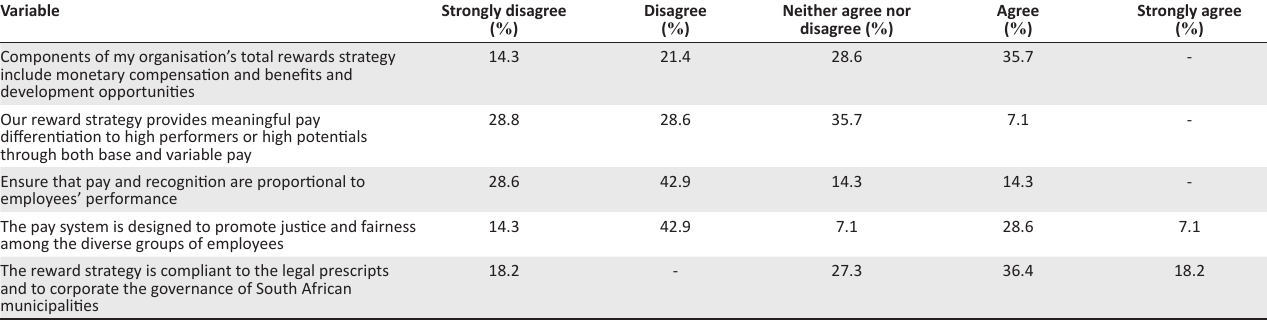
TABLE 2: Extent to which municipalities use selected practices as part of total reward strategy. Variable